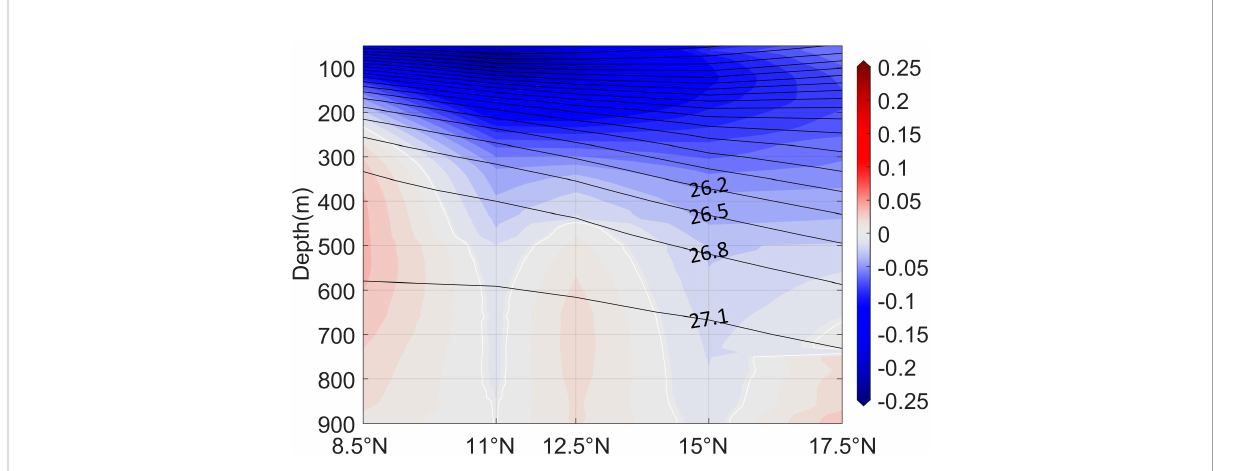
FIGURE 3 Mean zonal velocity (color, m/s) along 130°E section derived from all the mooring ADCP measurements during 2014-2021. Black curves denote potential density surfaces derived from WOA18.